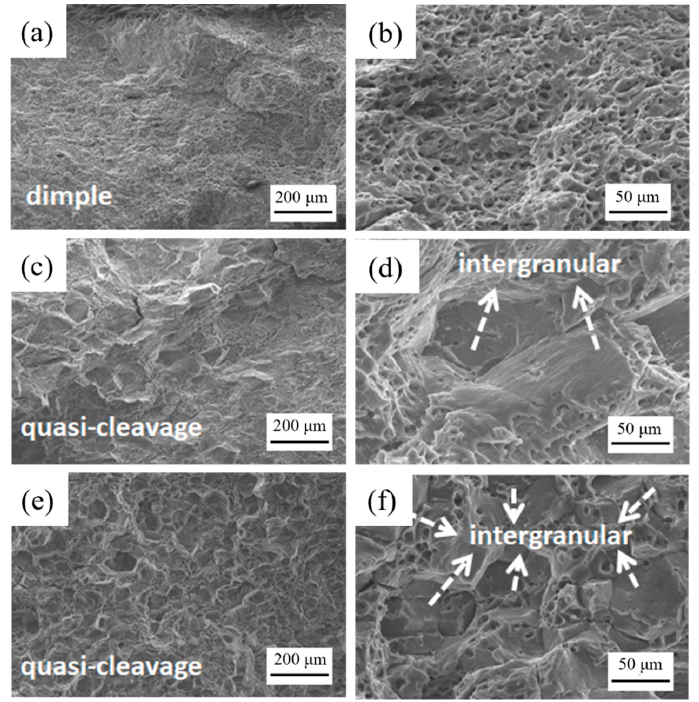
Figure 7. Local characteristics of tensile fracture of samples with different irradiation fluence: ( a , b ) unirradiated specimen; ( c , d ) thermal neutron fluence of 0.54 × 10 21 n/cm 2 ; ( e , f ) thermal neutron fluence of 2.38 × 10 22 n/cm 2 .